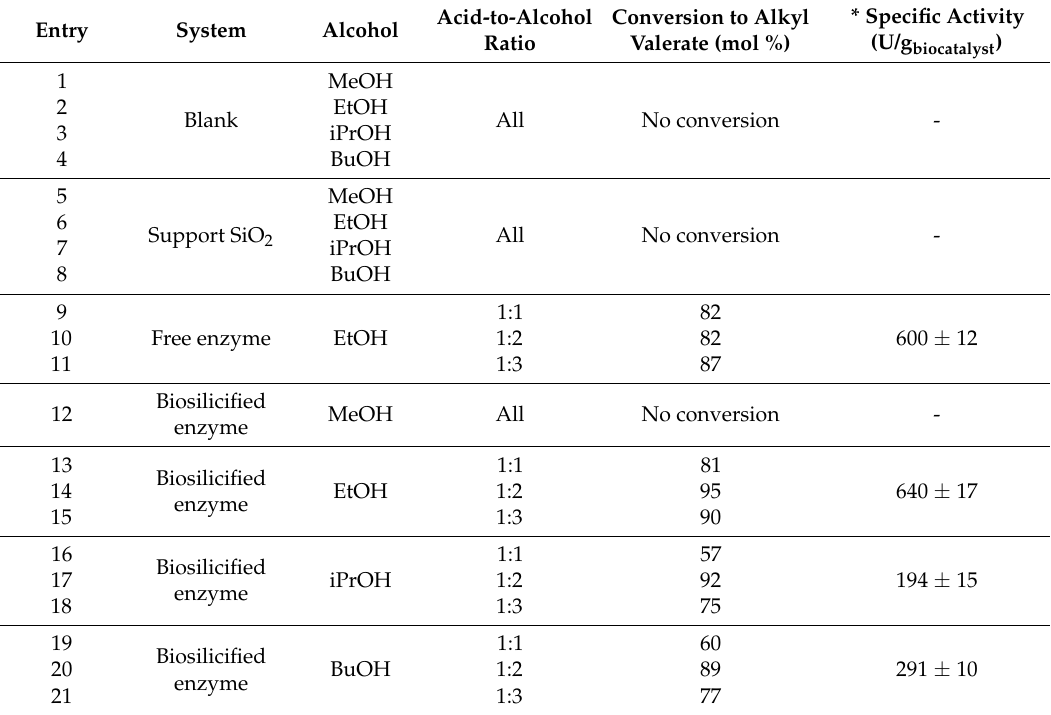
Table 5. CH esterification of valeric acid using different alcohols (MeOH, EtOH, iPrOH, BuOH) and different acid-to-alcohol molar